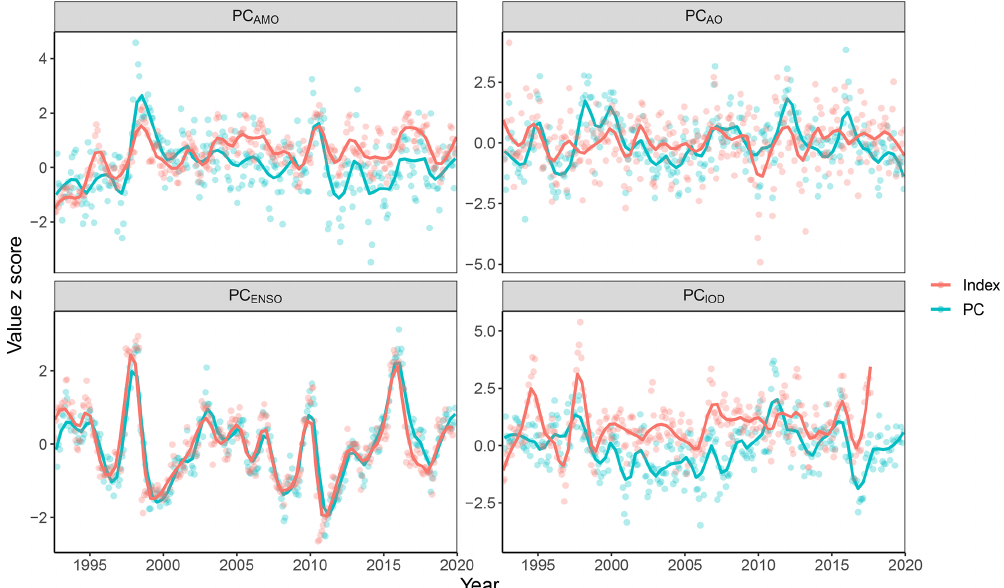
Figure 4. Time series of background climate variation for the four PCs that were most influential in the best models of water level variation on average across lakes. PCs (PC AMO , PC AO , PC ENSO , and PC IOD ) and their corresponding climate indices (AMO, AO, ENSO, and IOD) are transformed to their z scores so that they can be more easily compared on the same unit-less scale. The dots represent raw values, and the lines represent locally weighted scatterplot (LOWESS)-smoothed time